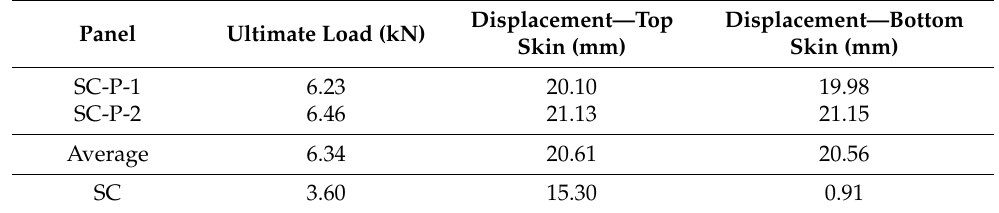
Figure 4. Load vs. displacement of single-cell panels. Table 2. Results of single cell panel tests.